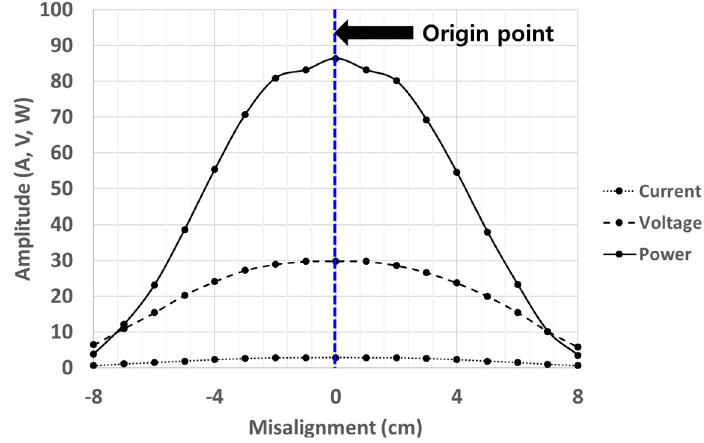
Figure 20. Voltage and current measured at the load, and its calculated power (first experiment: static load).